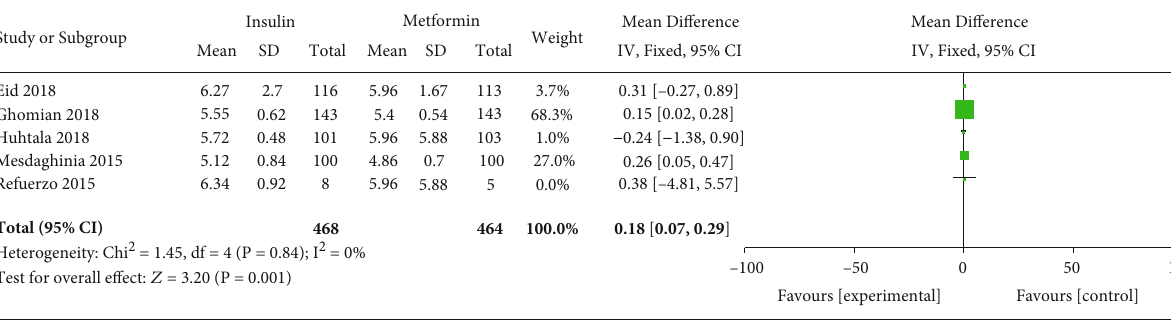
Test for overall effect: Z = 3.20 (P = 0.001)